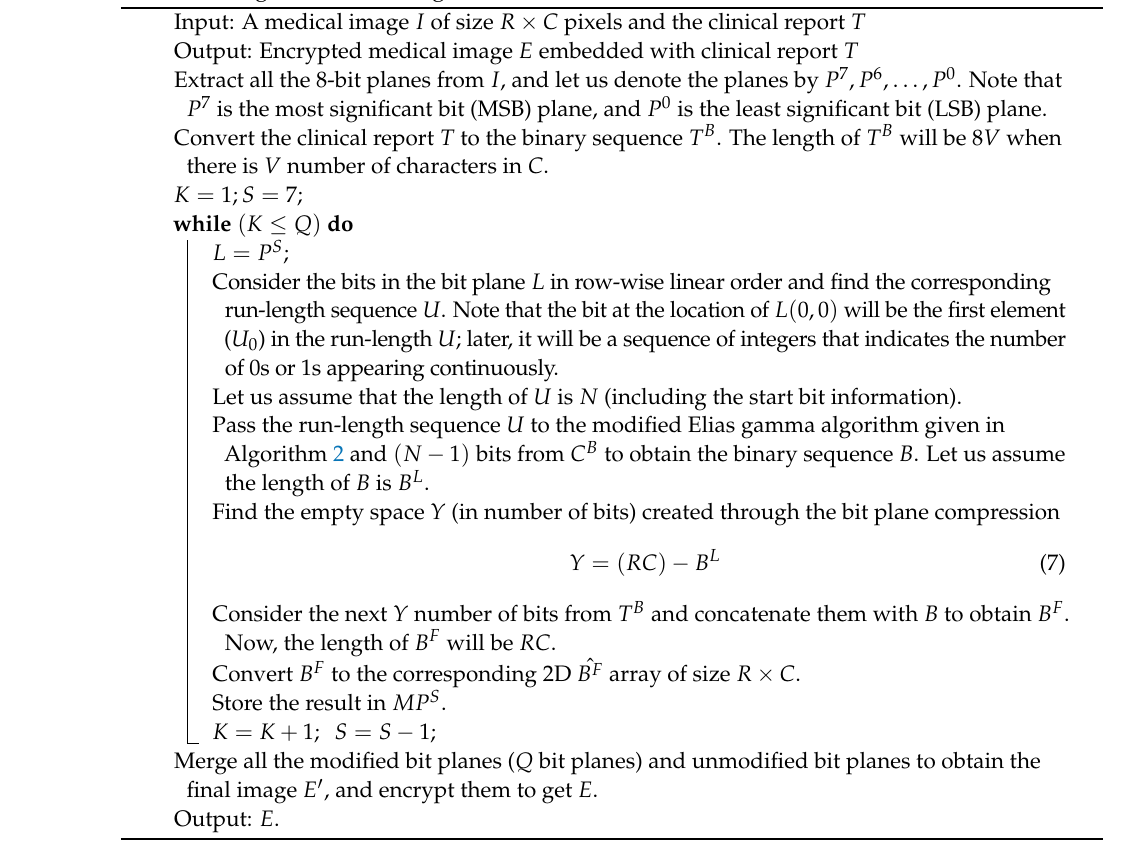
Algorithm 2: Modified Elias gamma approach for variable length